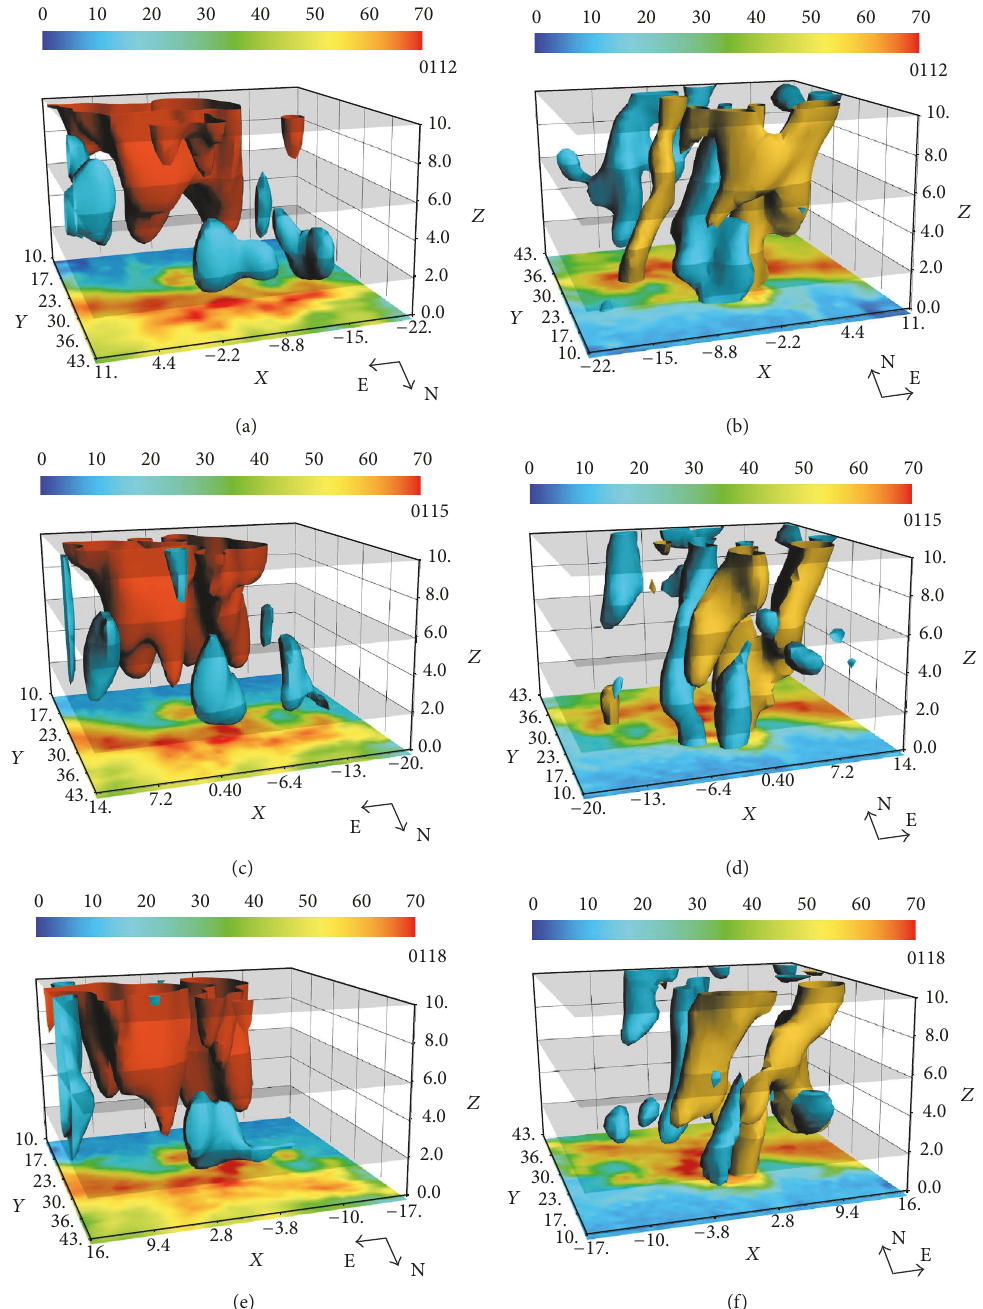
Figure13:SameasFigure4,exceptduringtheorganizingstageofthethirdmesocycloneandtheorientationhaschanged.Theverticalvelocity (panels (a), (c), and (e)) is from the perspective of looking at the storm from roughly the north. The vorticity (panels (b), (d), (f)) is from the perspective of looking at the storm from roughly the